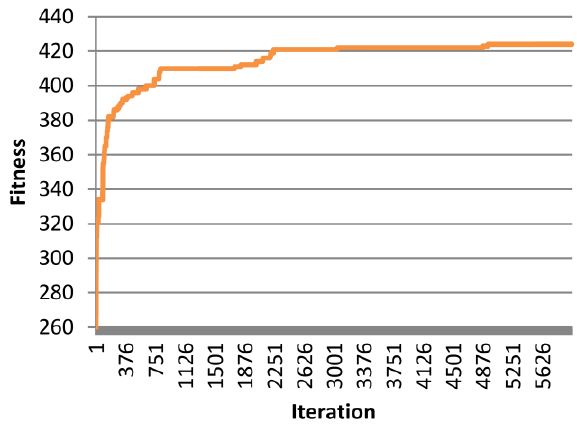
= 2, c = 2, χ = 0.72984, V = −3~3). 1 2